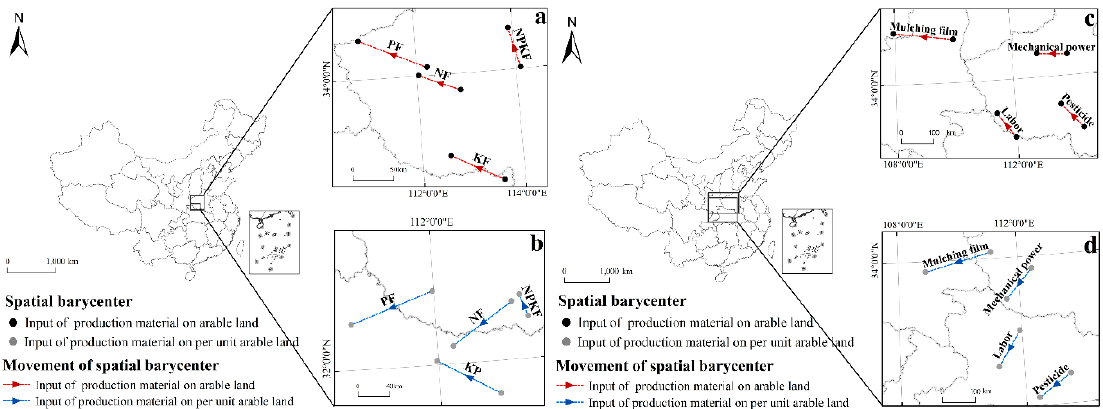
Figure 10. The movement of the spatial barycenter for the input on arable land (NF refers to nitrogen fertilizer; PF refers to phosphorus fertilizer; KF refers to potash fertilizer; NPKF refers to compound fertilizer).